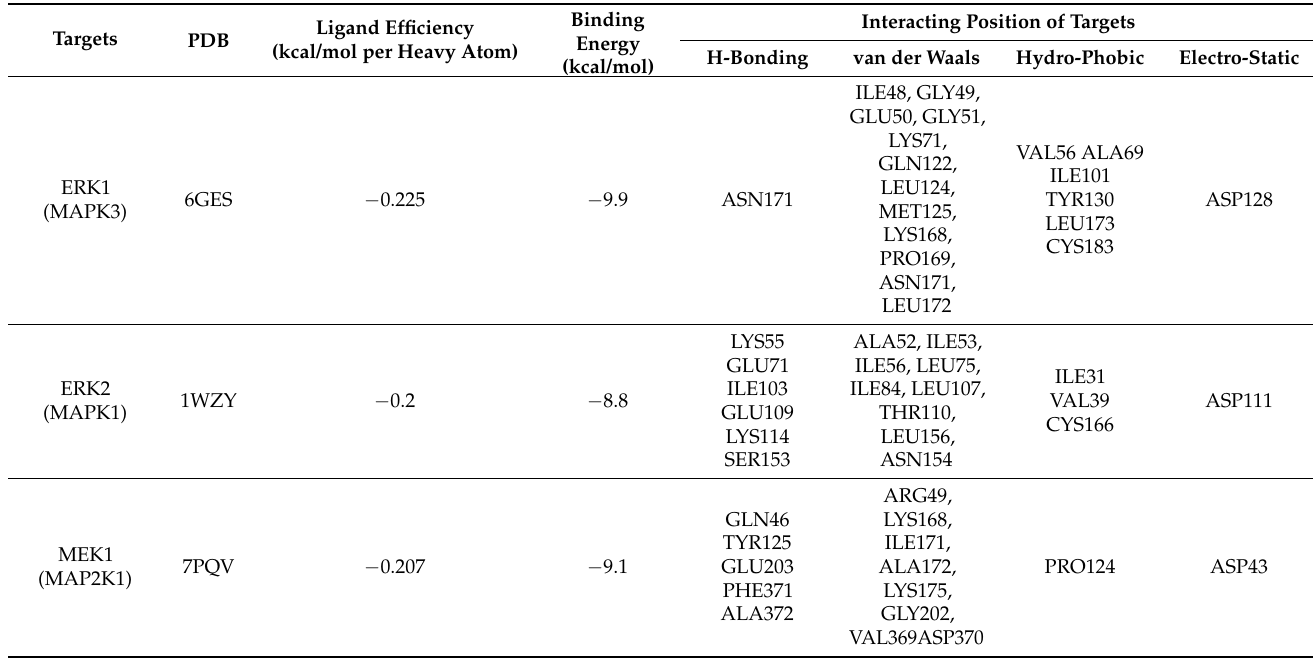
Table 2. Interaction strength between 22-(4 (cid:48) py)-JA and potential targets. Binding Interacting Position of Targets Ligand Efficiency Targets PDB Energy (kcal/mol per Heavy Atom) H-Bonding van der Waals Hydro-Phobic (kcal/mol)